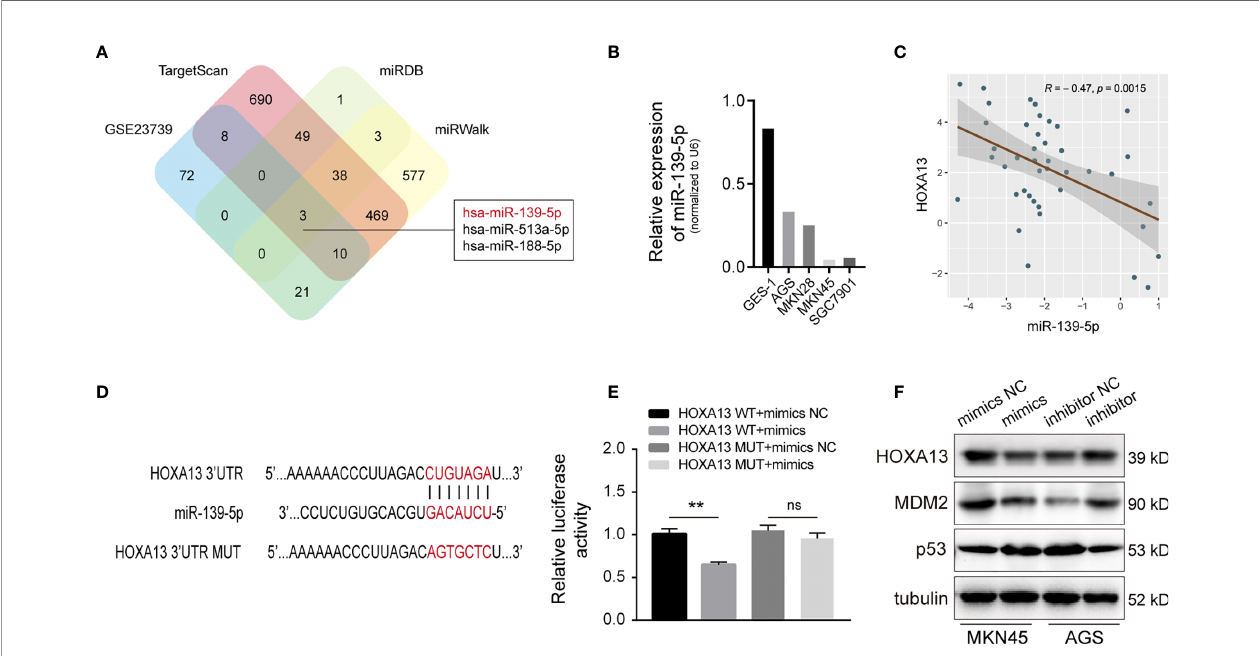
FIGURE 7 | HOXA13 is directly targeted by miR-139-5p in GC. (A) Potential miRNAs that target HOXA13 were predicted by GEO dataset and online prediction tools. (B) Relative expression levels of miR-139-5p in cell lines were detected by qRT-PCR. (C) Pearson ’ s correlation analysis of the mRNA levels of miR-139-5p and HOXA13 in GC samples. (D) The predicted miR-139-5p binding site in HOXA13 and sequences of wild-type (WT) and mutant (MUT) 3 ’ -UTR of HOXA13. (E) Relative luciferase activity were performed in HEK-293T cells after co-transfection with HOXA13 WT or HOXA13 MUT and miR-139-5p mimics or NC. (F) The protein expression levels of HOXA13, MDM2 and p53 were detected in MKN45 cells transfected with miR-139-5p mimics or NC and AGS cells transfected with miR-139-5p inhibitor or NC. ** P < 0.01. ns, no signi fi